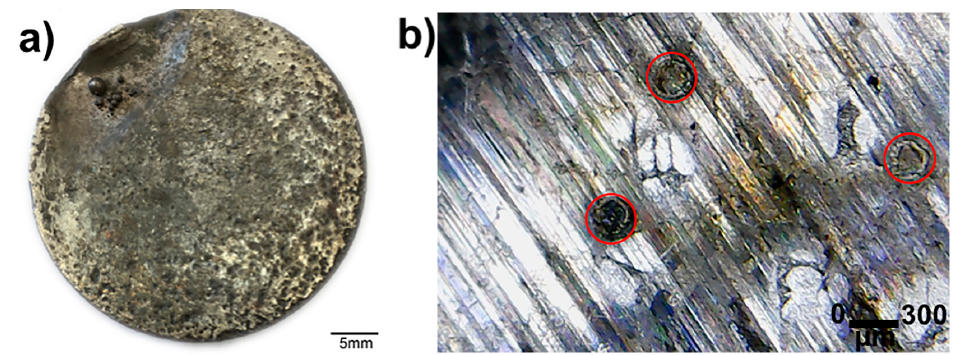
Figure 3. The pig iron circular disc showing the rough face with small shrinkages ( a ); laser beam craters (red circles) produced on the surface ( b ). (red circles) produced on the surface ( b